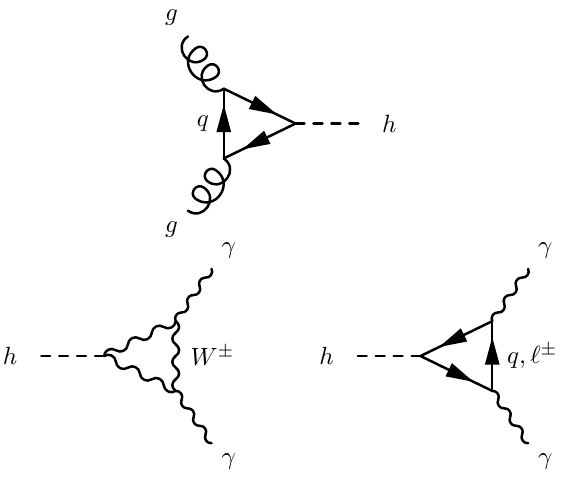
Fig. 1. Representative diagrams involved in Higgs production by gluon fusion (top) and subsequent decay to photons (bottom).